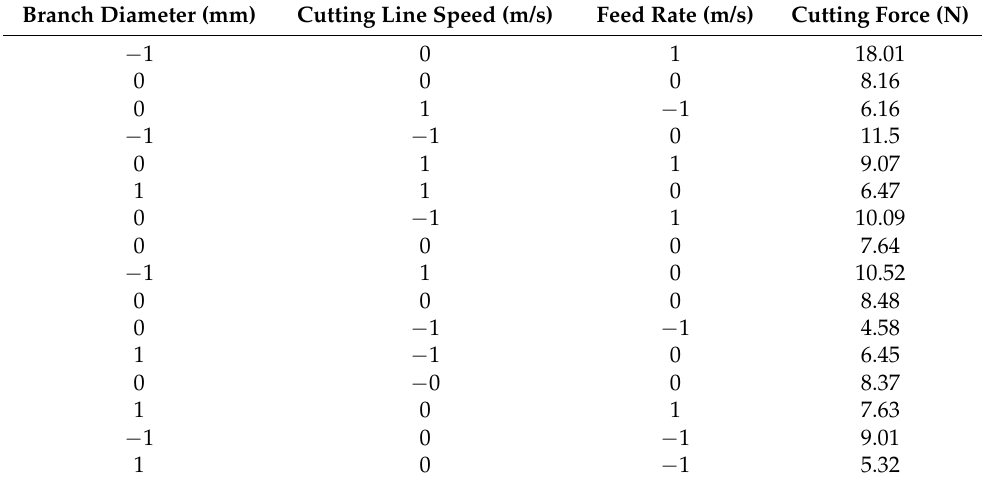
Table 2. Design and results of full factorial